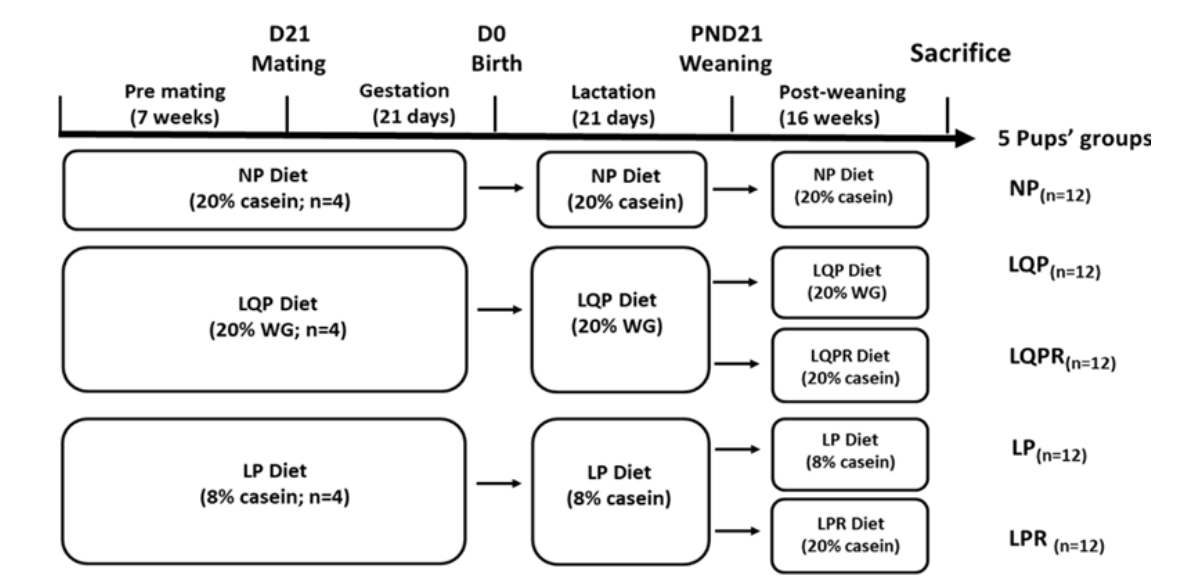
Figure 1. Experimental design: Female WNIN rats were alimented with either a normal protein (NP) diet with 20% casein ( n = 4) or a low-quality protein (LQP) with wheat gluten (WG) diet ( n = 4), or a low-protein (LP) diet with 8% casein ( n = 4) for 7 weeks, followed by mating with males. All of the animals received the same diet throughout gestation and lactation. At the weaning, the offspring were assigned into the following groups: NP diet ( n = 12), LQP diet ( n = 12), LQPR diet (a group of offspring from the LQP group rehabilitated with an NP diet; n = 12), LP diet ( n = 12), LPR diet (a group of offspring from the LP group rehabilitated with the NP diet; n = 12). The offspring were sacrificed after maintaining their respective diets for 16 weeks after weaning. Table 1. Composition of the diets used in the study.